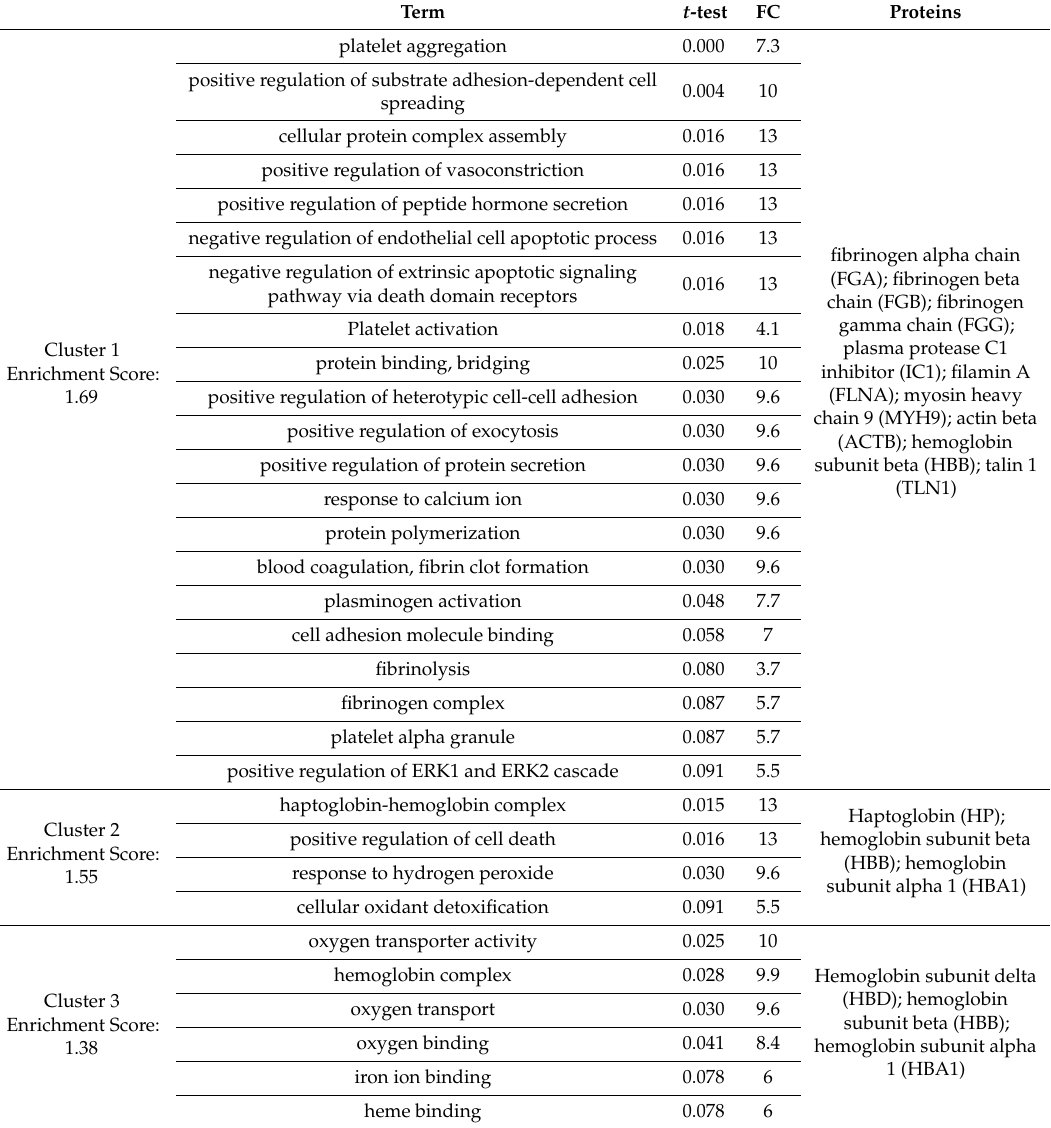
Table 2. Results of the functional annotation clustering showing the p -value of each term and the fold change